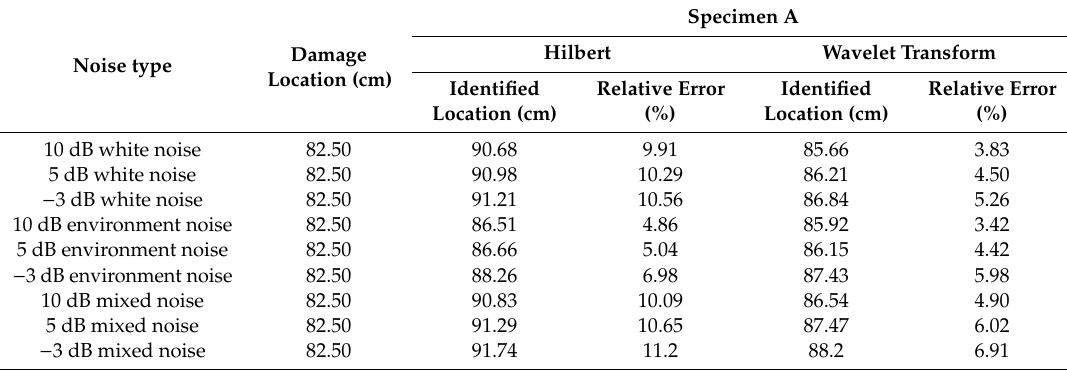
Table 3. Statistics of damage location results of specimen A under di ff erent feature extraction